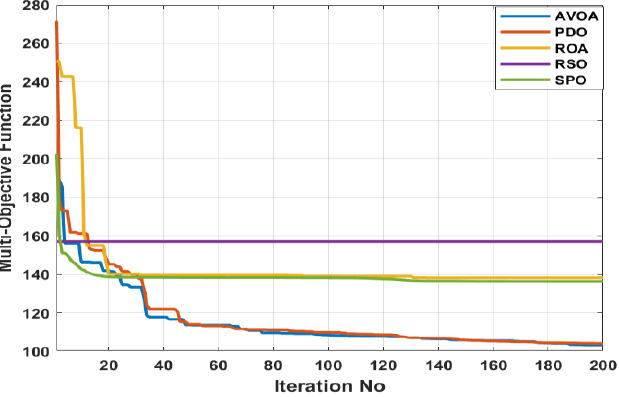
Figure 11. The AVOA convergence characteristics with the other compared methods for case 5.